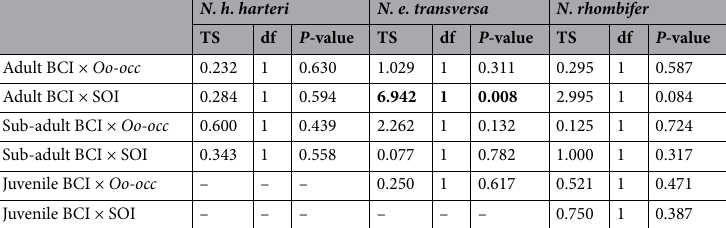
Table 3. Summary statistics from Kruskal–Wallis One Way ANOVA tests (TS = test statistic; df = degrees of freedom) for differences in body condition (BCI) when considering O. ophiodiicola occurrence ( Oo-occ ) and signs of infection (SOI) across life stages of Nerodia rhombifer , N. e. transversa , and N. h. harteri . Significant results are in bold